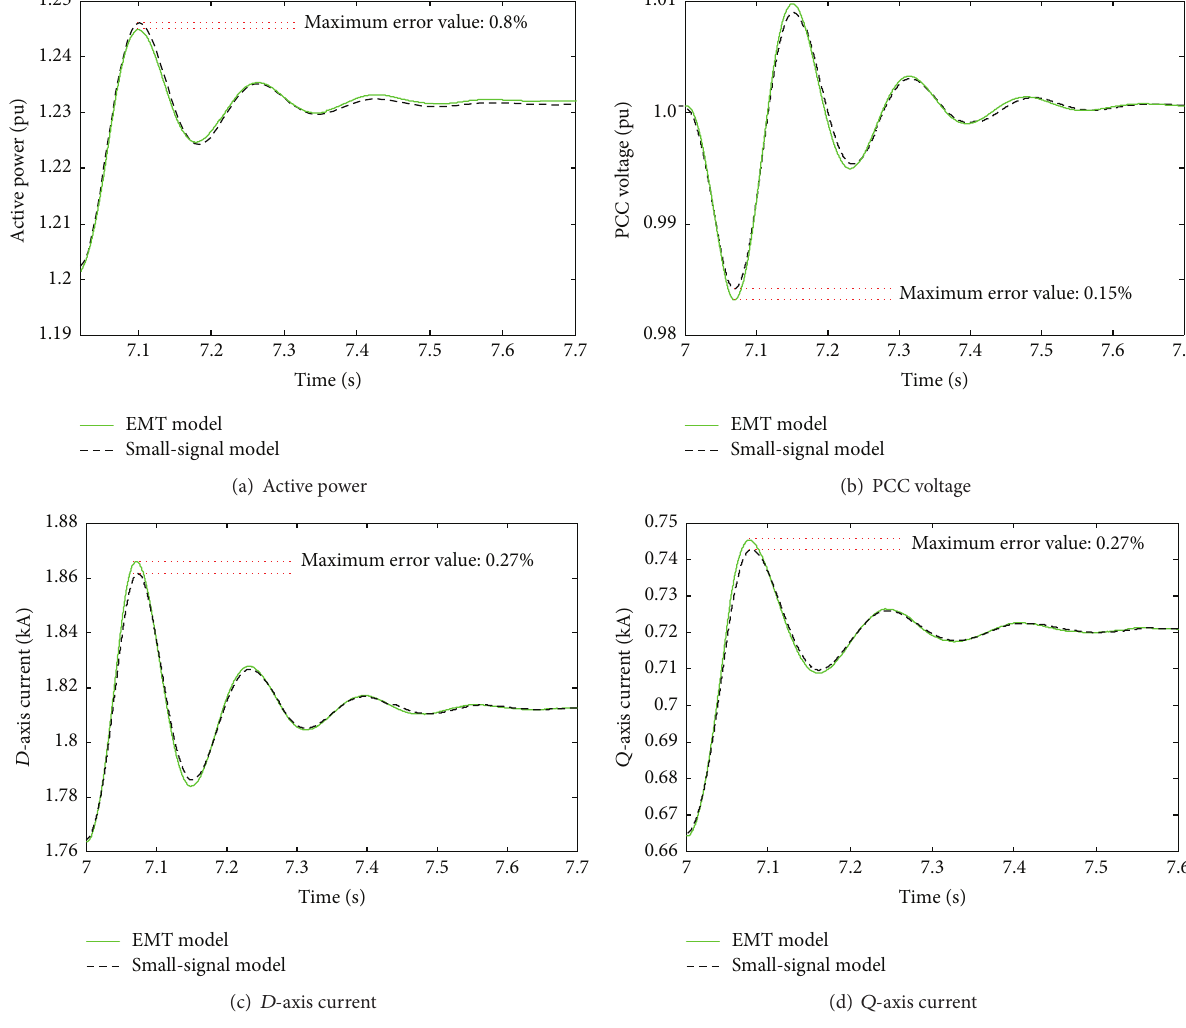
Figure 8: Simulation results of VSC system (impedance angle is 85 ∘ ).